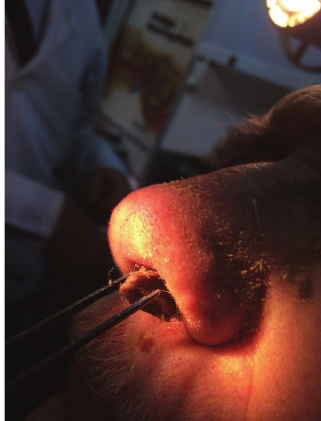
Figure 1: Mass was developed as seen from the left nasal cavity of lateral wall of vestibule.